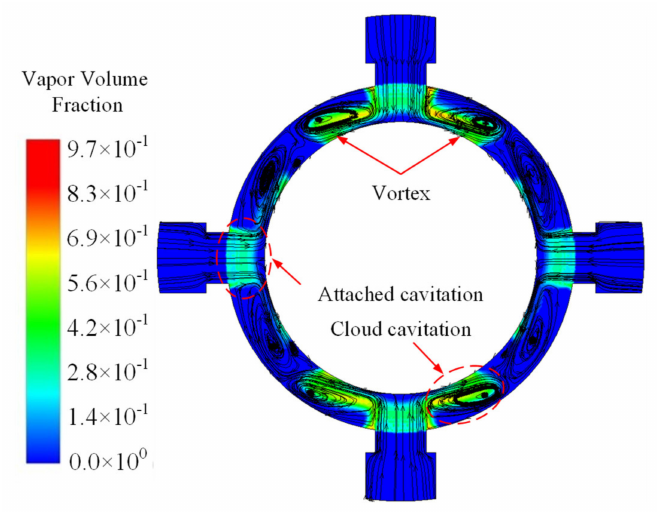
Figure 8. Streamline and cavitation on the section parallel to the convex shoulder surface.